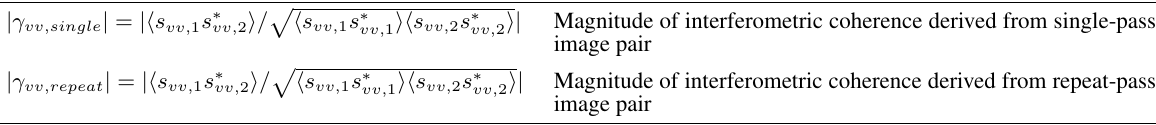
Table 1. Polarimetric and interferometric features, extracted to build a high dimensional representation of PolInSAR